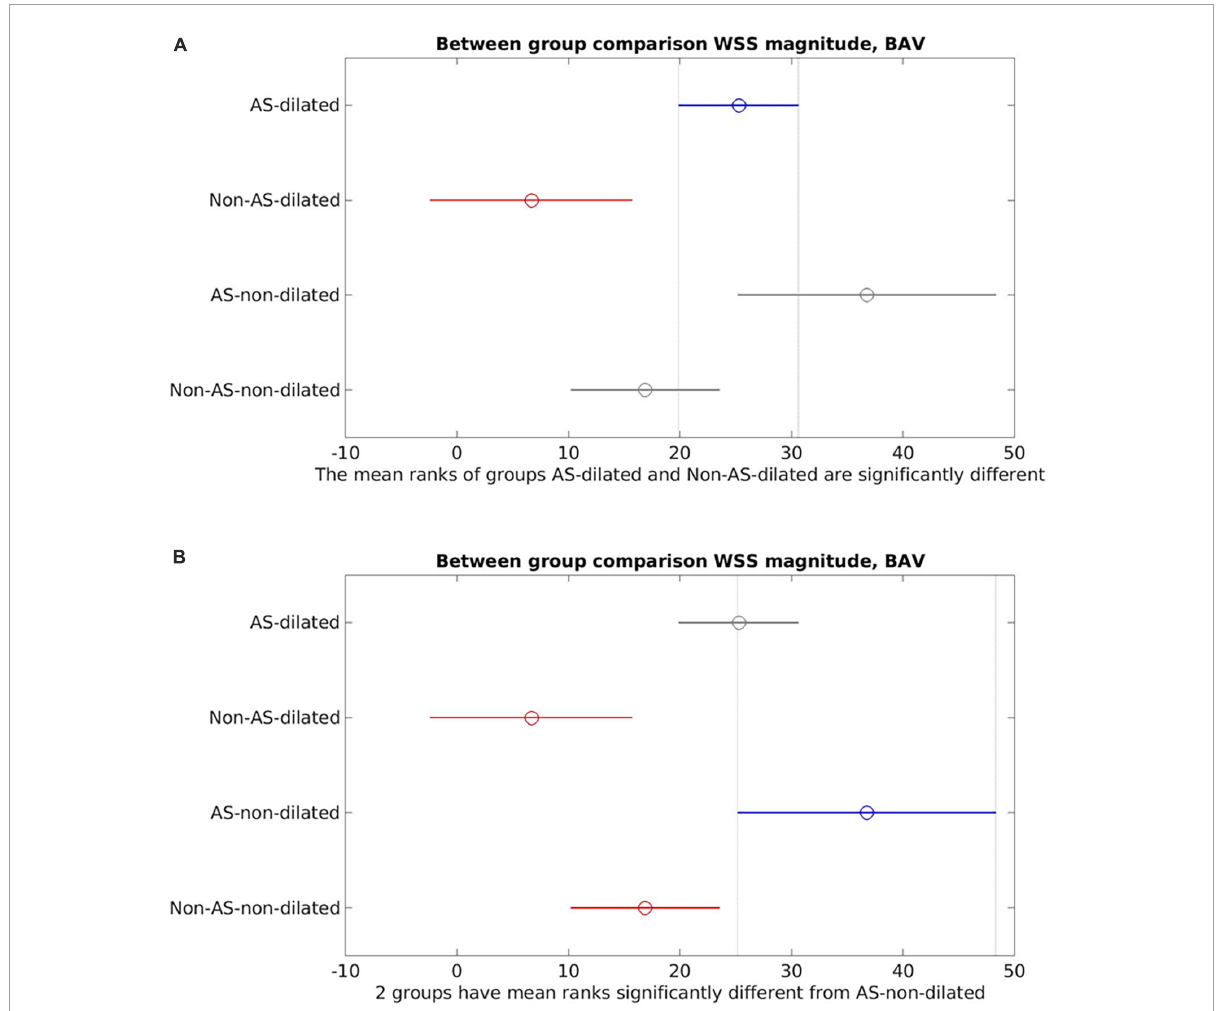
FIGURE6 Between-group comparisons of aortic stenosis (AS)-dilated, AS-non-dilated, Non-AS-dilated, Non-AS-non-dilated in the bicuspid aortic valve (BAV) cohorts. (A) AS-dilated (blue) is the reference cohort. Non-AS-dilated (red) was statistically significantly different from the AS-dilated cohort. No statistically significant difference was found between AS-dilated and the non-dilated cohorts (gray). (B) AS-non-dilated (blue) is the reference cohort. Statistically significant difference was found between AS-non-dilated and the non-AS cohorts (red). No statistically significant difference between AS-non-dilated and AS-dilated